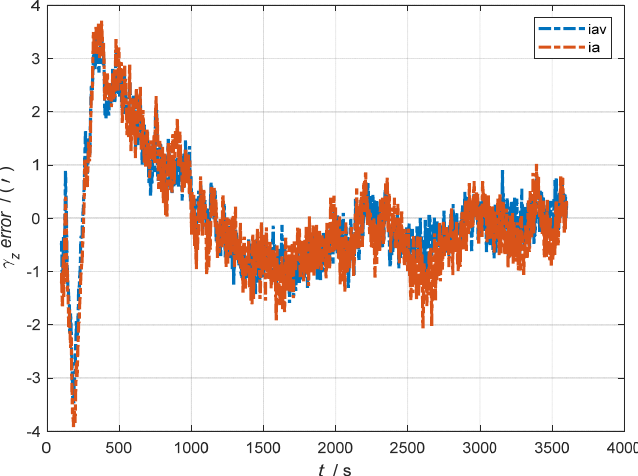
Figure 23. The error curves of γ y in the cases of the initial misalignment angles T [5 5 20 ] ° ° ° .